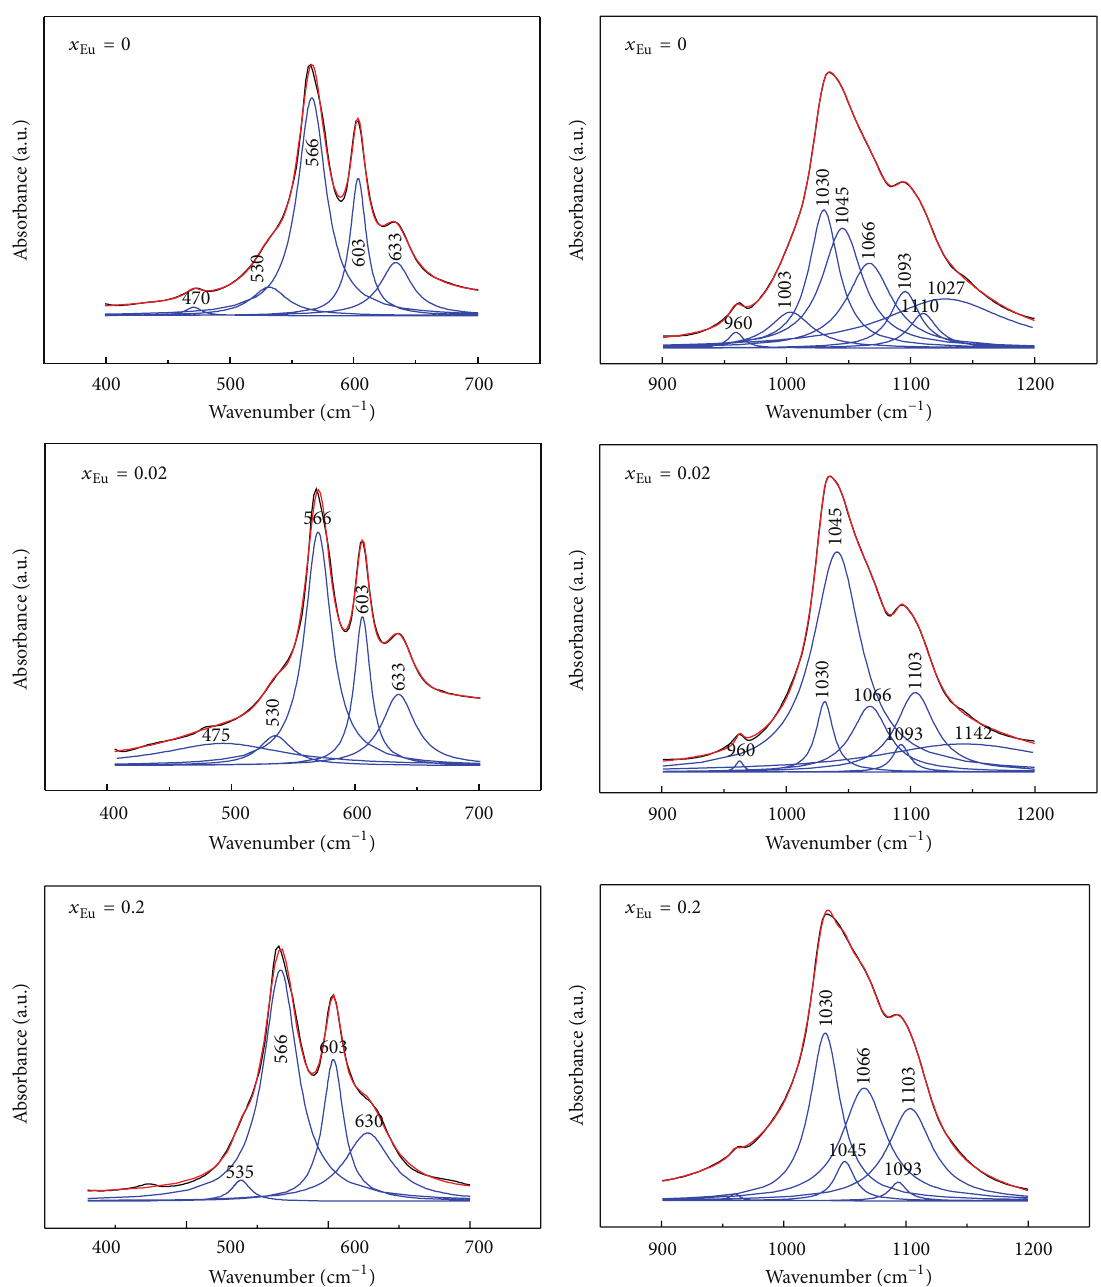
= 0 , 𝑥 = 0.02 , and 𝑥 = 0.2 ). Eu Eu Eu